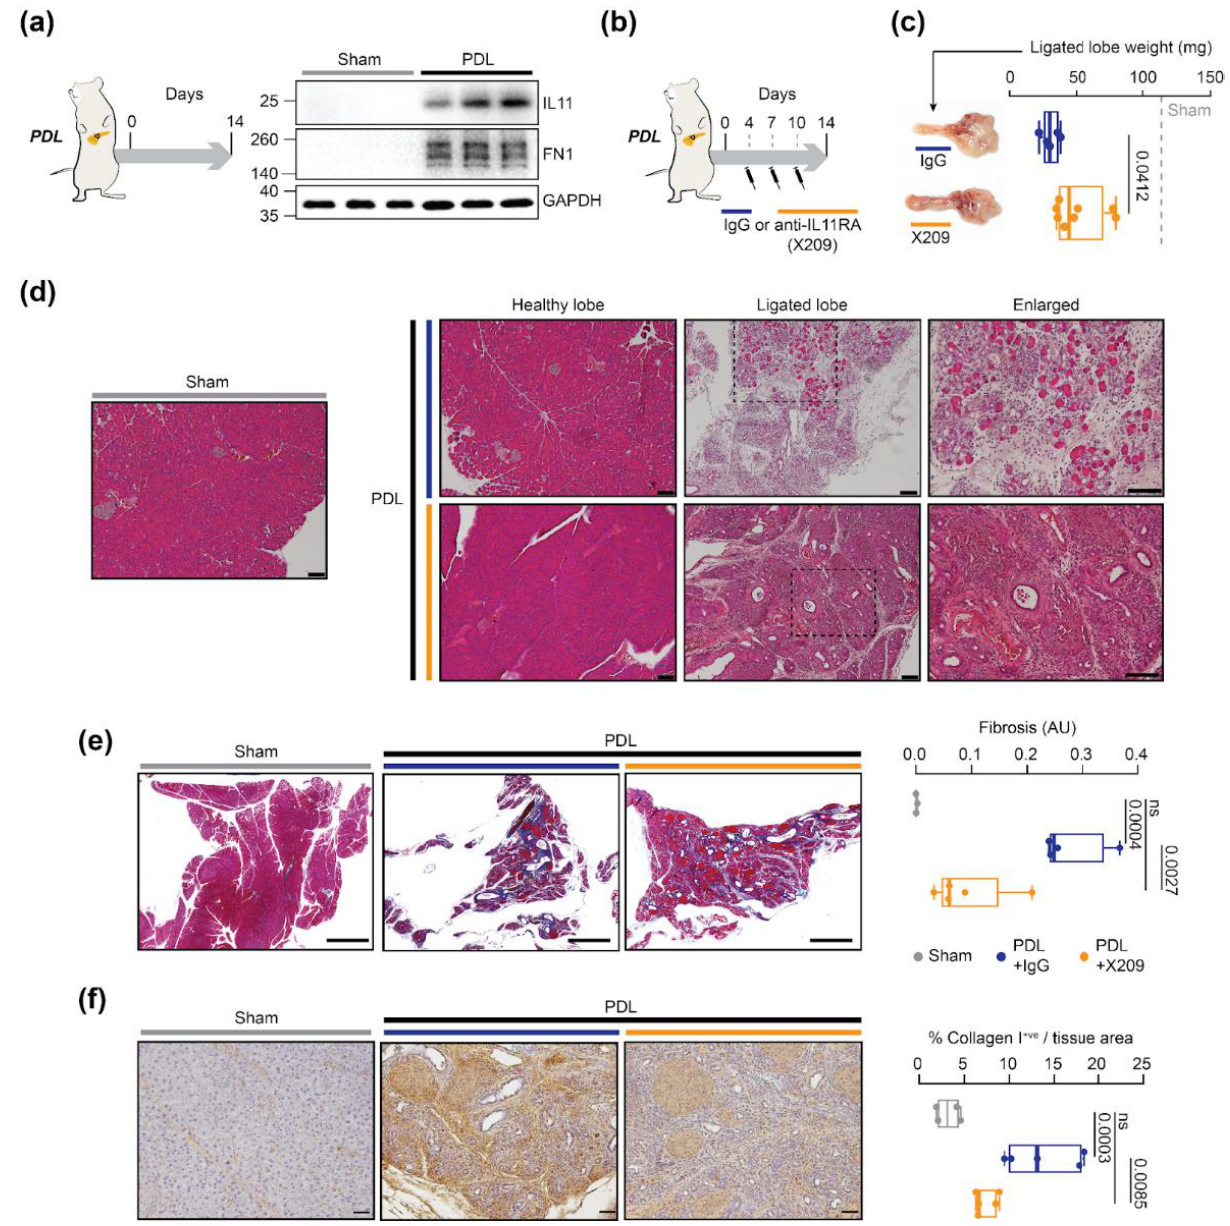
Figure 4. IL11RA antibody treatment reduces pancreatic fibrosis in a mouse model of pancreatitis. ( a ) Schematic of the induction of pancreatitis in wildtype C57BL/6 mice by pancreatic duct ligation (PDL) and Western blot analysis of IL11 and fibronectin (FN1) expression in pancreatic lysates post- sham or 14 days post-PDL surgery (n = 3/group). ( b ) Schematic of the administration timepoints of neutralizing IL11RA antibody (X209) or IgG control antibody treatment in the PDL model. ( c ) Gross pancreas anatomy and the tissue weights of the ligated splenic lobe in X209 or IgG treated mice. ( d ) Hematoxylin and eosin staining of pancreatic sections from the healthy or ligated splenic lobes of X209 or IgG treated mice. Scale bars: 100 µ m. ( e ) Masson’s trichrome staining images and collagen quantification of fibrosis in the ligated splenic lobes of X209 or IgG treated mice (n = 3–4). Scale bars: 1000 µ m. AU: arbitrary unit. ( f ) Collagen I immunostaining of the ligated splenic lobes of X209 or IgG treated mice. Scale bars: 50 µ m. Data shown as median and whiskers extending from minimum to maximum values. p values were determined by Student’s t -test in ( c ) and one way ANOVA (Tukey’s correction) in ( e , f ).